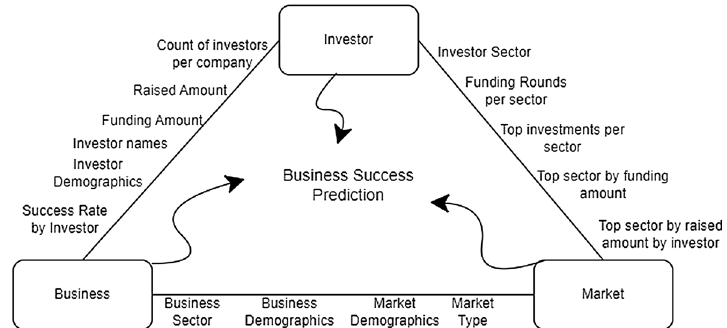
Fig. 2 IBM triangle interplay. Investor, Business, and Market are three separate aspects that impact the business success. Texts next to each edge outline representative features we propose to capture the interplay between